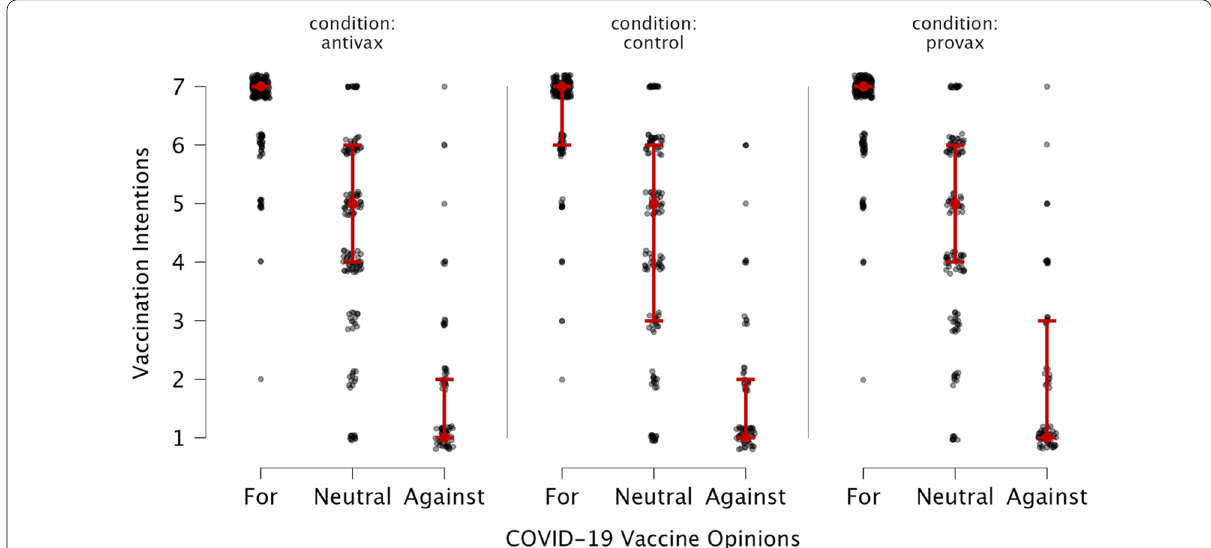
Fig. 2 Intentions to get vaccinated in Study 1, by experimental condition and pre-existing vaccine